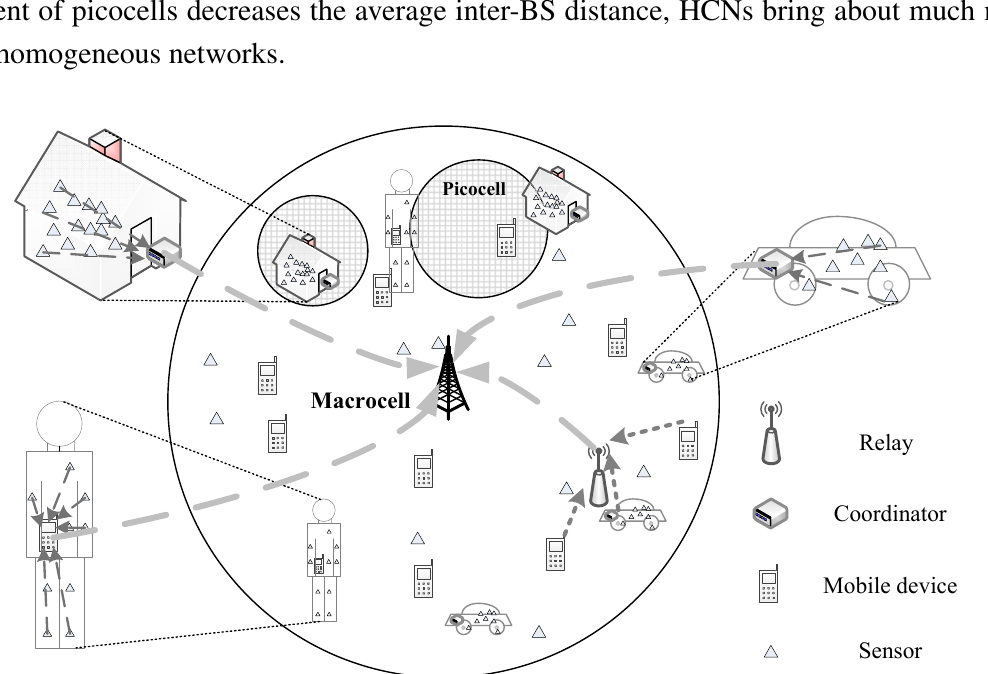
Figure 1. Scenario with multiple picocells and densely-deployed devices in a single